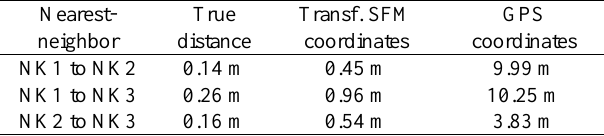
Table 2 : Most frequent nearest-neighbor distance between estimated camera viewpoints in transformed SFM coordinates and GPS coordinates.